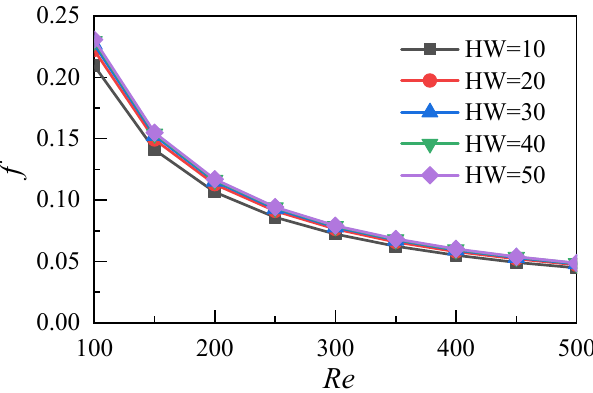
Figure 11. Distributions of friction coefficients.